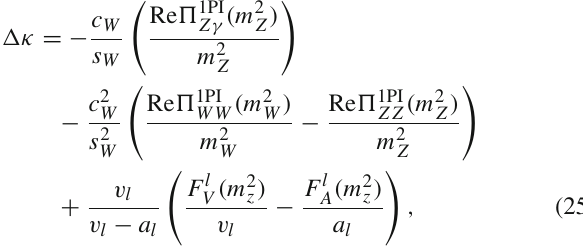
Table 1 Input parameters used in computation. Note that (cid:4)α is the sum of the hadronic contribution (cid:4)α ( 5 ) contribution (cid:4)α lept = 0 . 031497687 [90] α − 1 = 137 . 035999084, m em